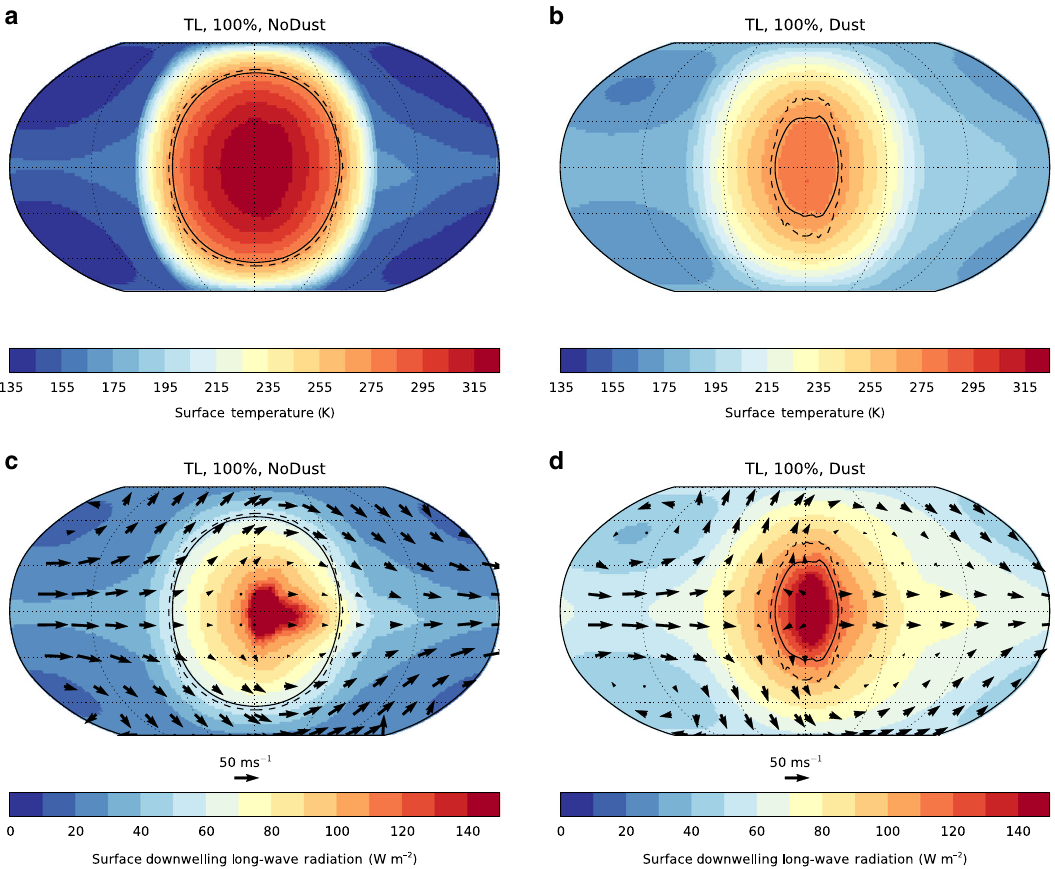
Fig. 3 Mechanisms driving surface temperature change. Surface temperature ( a , b ) and surface downwelling long-wave radiation ( c , d ), from the TL case with 100% landcover for the NoDust ( a , c ) and Dust ( b , d ) simulations. Also shown are the mean (solid) and maximum (dashed) 273-K contours, and wind vectors at 8.5 km ( ≈ 300 hPa, in c and d